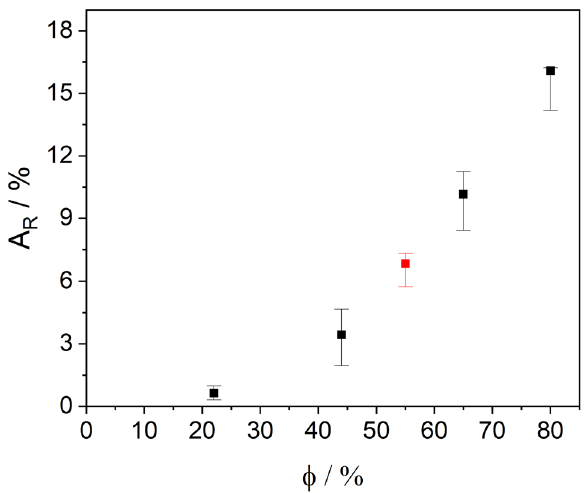
Figure 5. Correlation of the relative area of the holes during 18 h storage (black dots) at different degree of humidity, red dot at a humidity of φ = 55% end point from Figure 3b interpolated to 18